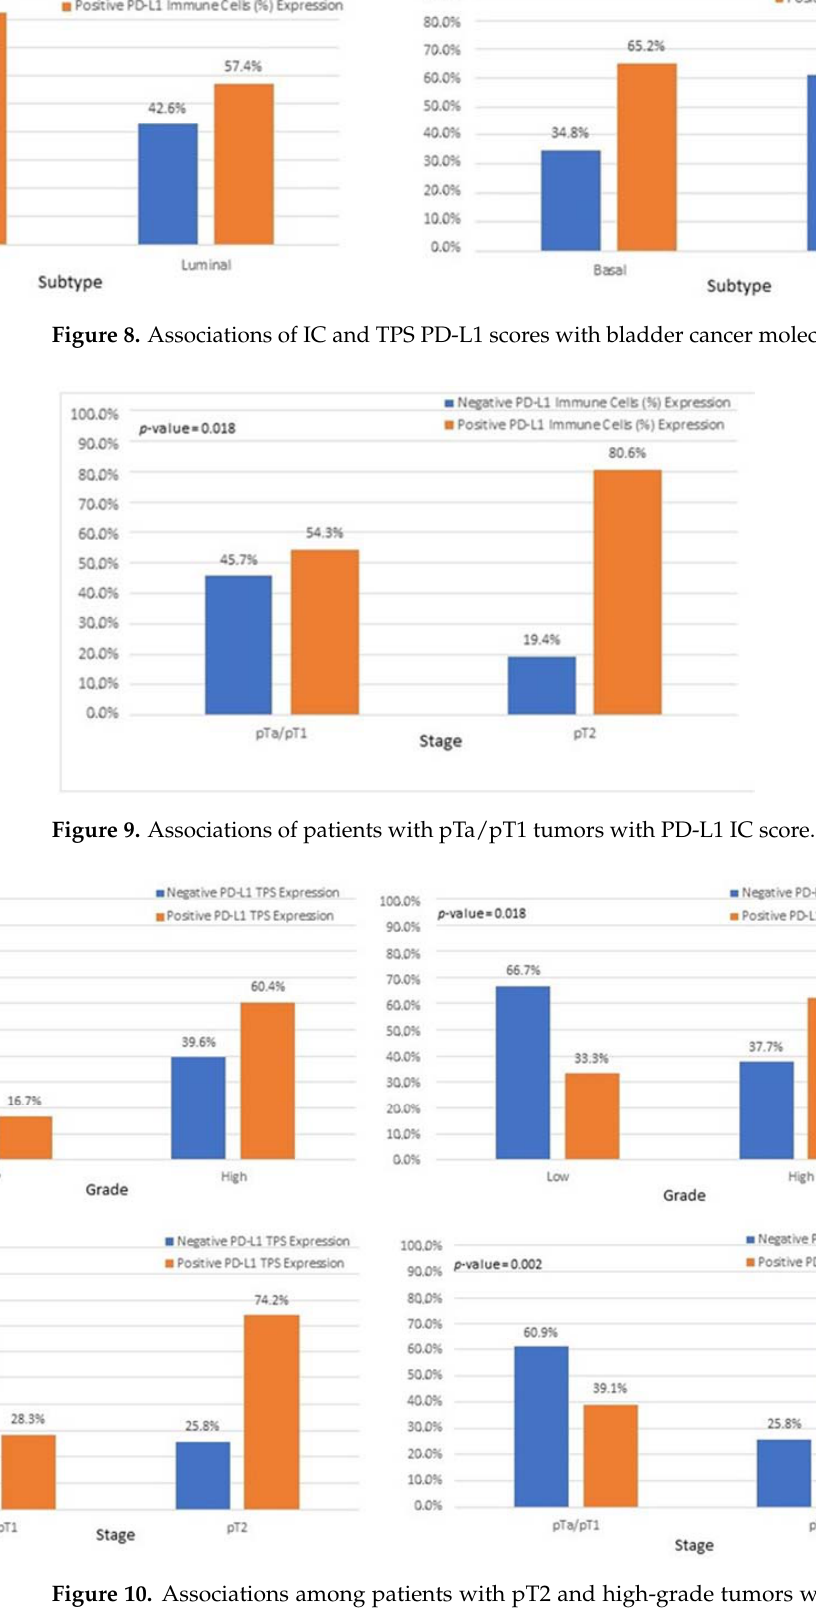
Figure 10. Associations among patients with pT2 and high-grade tumors with PD-L1 expression, based on CPS and TPS scores.